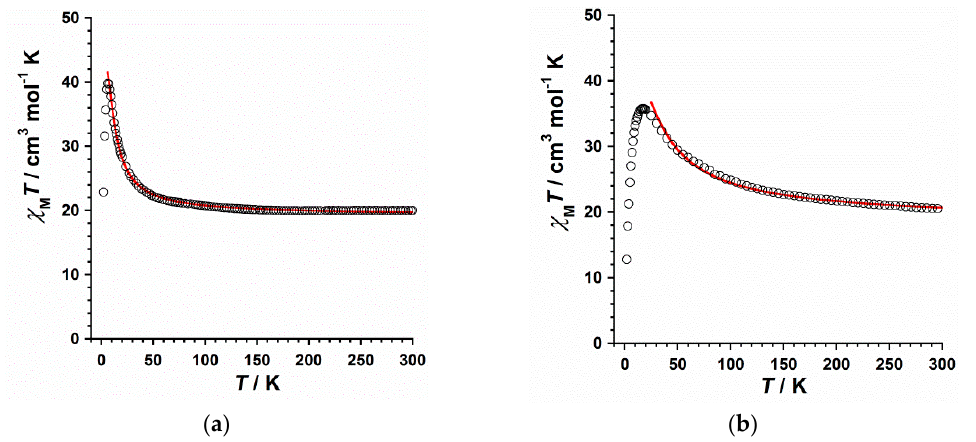
Figure 5. Thermal variation of the χ M T product for compounds 1 ( a ) and 2 ( b ). The solid red line represents the best-fit of the experimental data.